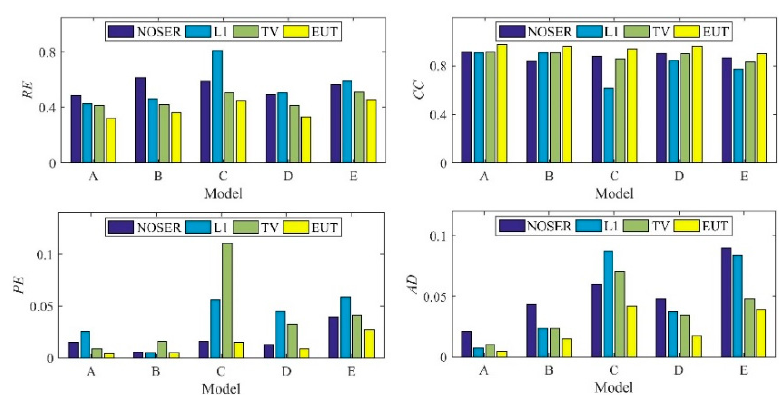
Figure 13. Quantitative analysis of the experimental results.